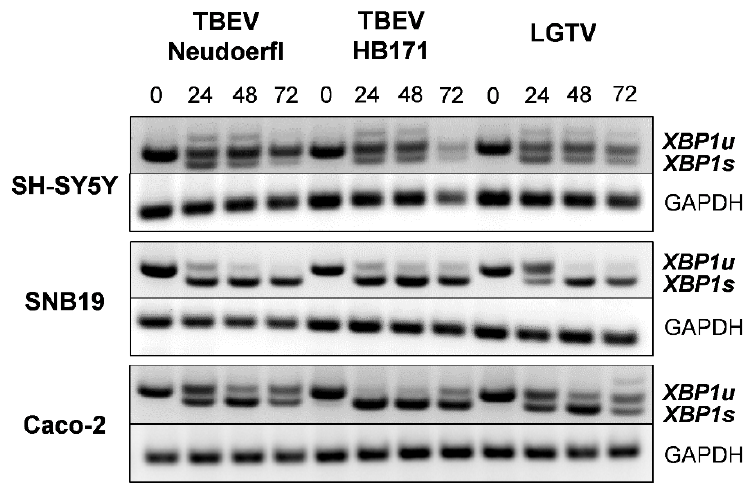
Figure 3. Analysis of XBP1 mRNA splicing by IRE1 after infection of neuronal (SH-SY5Y), astrocyte (SNB19) and intestinal (Caco-2) cells with the different tick-borne flaviviruses. Cells were infected at multiplicity of infection of 0.1 and cell lysates were collected at 0, 24, 48 and 72 h post infection. Cellular RNA was extracted from lysates, quantified by RT-PCR and analyzed on an agarose gel. Spliced XBP1 (XBP1s) can be distinguished from unspliced XBP1 (XBP1u) by a shift towards a lower molecular weight. GAPDH was used as a housekeeping control. The experiment was repeated three times and a representative gel is shown.